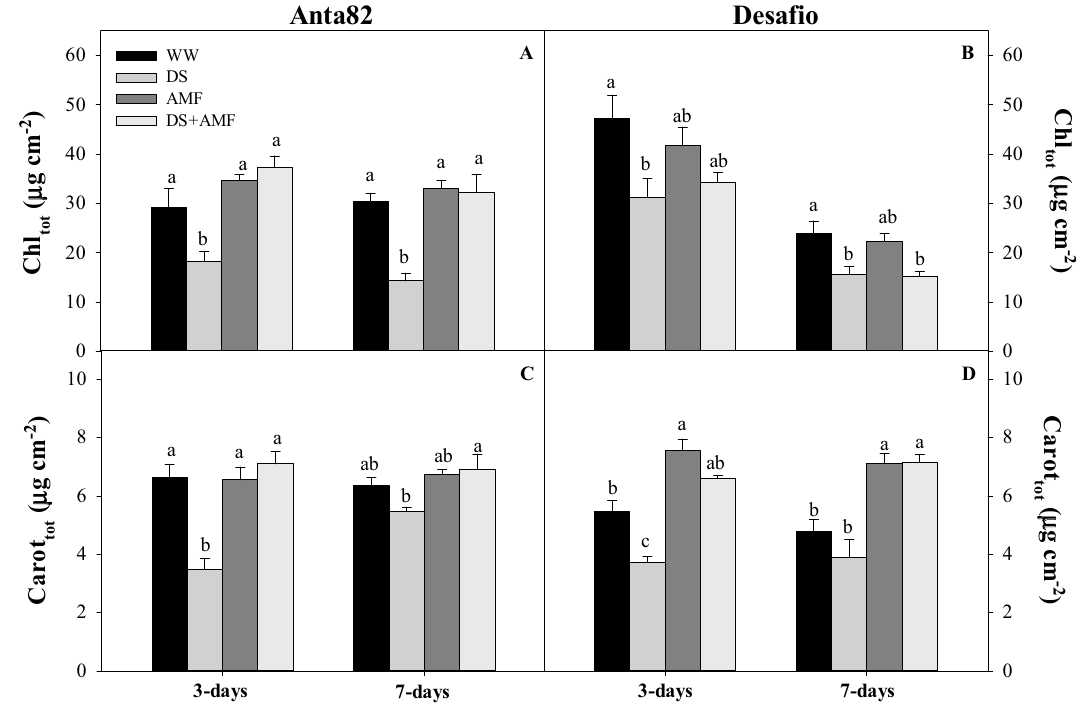
Figure 6. Total chlorophyll (Chl tot ) and total carotenoid (Carot tot ) contents on days 3 and 7 in the ( A , C ) Anta82 and ( B , D ) Desafio soybean cultivars under different conditions of inoculation and water stress. WW = well- watered, noninoculated, DS = drought stress, noninoculated, WW + AMF = well-watered and inoculated, DS + AMF = drought stress and inoculated. The bars represent the mean ± SEM ( n = 4). Pairs of means in the same period (3 or 7 days) with different letters are significantly different ( p < 0.05) based on Tukey’s post hoc ETR: F 3.15 = 6.078 , p = 0.0093) (Fig. 5F,H). Non-photochemical quenching (NPQ) was significantly higher in the DS and DS + AMF groups than in the WW group on day 3 (F 3.15 = 9.428; p = 0.0018). On day 7, the NPQ of the inoculated plants (AMF and DS + AMF) was no different from that of the WW group (Fig. 5J). Photosynthetic pigments. The total chlorophyll and carotenoid concentrations were reduced signifi- cantly in the DS plants of the Anta82 cultivar after 3 (F 3.15 = 11.16, p = 0.0009; F 3.15 = 15.84, p = 0.0002, respec- tively) and 7 days (F 3.15 = 14.39, p = 0.0003, F 3.15 = 4.257 , p = 0.0289, respectively) (Fig. 6A,C). In the cultivar Desa- fio, total chlorophyll was reduced significantly in the DS and DS + AMF plants in comparison with the WW group on day 7 (F 3.15 = 15.05 , p = 0.0002) (Fig. 6B). The carotenoid concentration was significantly higher on days 3 (F 3.15 = 31.95 , p = 0.0002) and 7 (F 3.15 = 15.05 , p = 0.0002) in the AMF and DW + AMF plants (Fig. 6D). Morphological traits. In the Anta82 cultivar, plant height (F 3.15 = 9.421 , p = 0.0018), leaf area (F 3.15 = 41.140 , p < 0.0001), and leaf dry matter (F 3.15 = 8.385 , p = 0.0028) were all reduced significantly in the DS and DS + AMF plants in comparison with the WW group on day 7 (Fig. 7A,E,G). Stem diameter and root dry matter were not affected by either treatment in Anta82 on either day 3 (F 3.15 = 0.475 , p = 0.7053; F 3.15 = 3.043 , p = 0.0704, respec- tively) or day 7 (F 3.15 = 1.463 , p = 0.2740; F 3.15 = 1.173 , p = 0.3609) (Fig. 7C,I). In the case of the Desafio cultivar, by contrast, neither plant height (day 3: F 3.15 = 2.170 , p = 0.1446; day 7: F 3.15 = 0. 945 , p = 0.4495), stem diameter (day 3: F 3.15 = 0.336 , p = 0.7998; day 7: F 3.15 = 1.124 , p = 0.3780) and root dry matter (day 3: F 3.15 = 2.675 , p = 0.0944; day 7: F 3.15 = 1.502 , p = 0.2641) were altered significantly by the treat- ments (Fig. 7B,D,J). However, leaf area (F 3.15 = 4.094 , p = 0.0324) and leaf dry matter (F 3.15 = 20.058 , p < 0.0001) increased significantly by day 7 in the inoculated plants (AMF and DS + AMF) in comparison with the WW group (Fig. 7F,H). Principal components analyses. The first two components explained 43.4% of the variance in the Anta82 data and 46.9% of that in the Desafio data. The plot of the first two PCA axes clearly differentiated a DS cluster from the other groups in the Anta82 data (Fig. 8A,B). The first PCA axis of the Desafio data, which explains 24.6% of the variance, is not systematically related to the different treatments (Fig. 8C,D), while the second axis clustered the DS records to the negative side of the plot, the DS + AMF and WW in the middle, and the AMF records toward the positive side. In the case of the Anta82 cultivar, most of the variables (LDM, E , Ψw, Chl, Carot, S root , g S , A , ETR, RDM, Y II , F v /F m , Mg leaf , Nleaf, MCR, C i /C a , SD, PH, Ca leaf , and Ca root ) were significantly correlated ( p < 0.05) with the first PCA axis, which means that